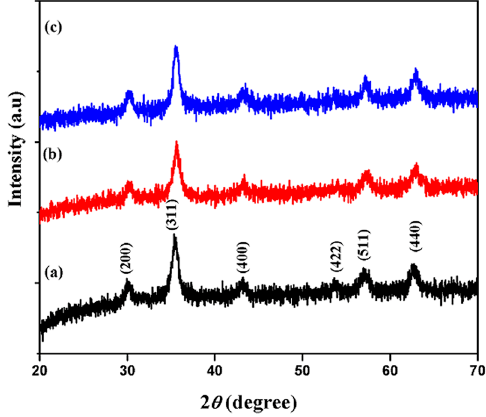
Figure 1. XRD patterns of sample ( a ) S1; ( b ) S2; and ( c ) S3.